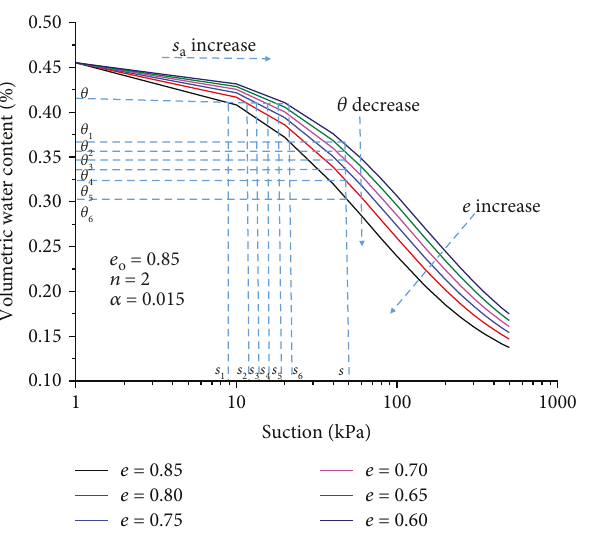
Figure 13: In fl uence of e on the SWCC.